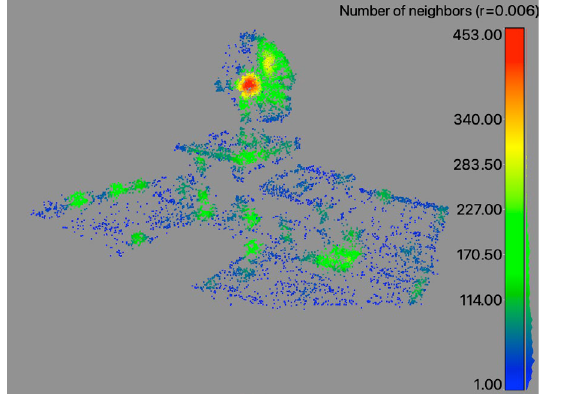
Figure 15. 3D reconstruction of the Rooftop with antenna. Table 8. Input and output overview of case 2.